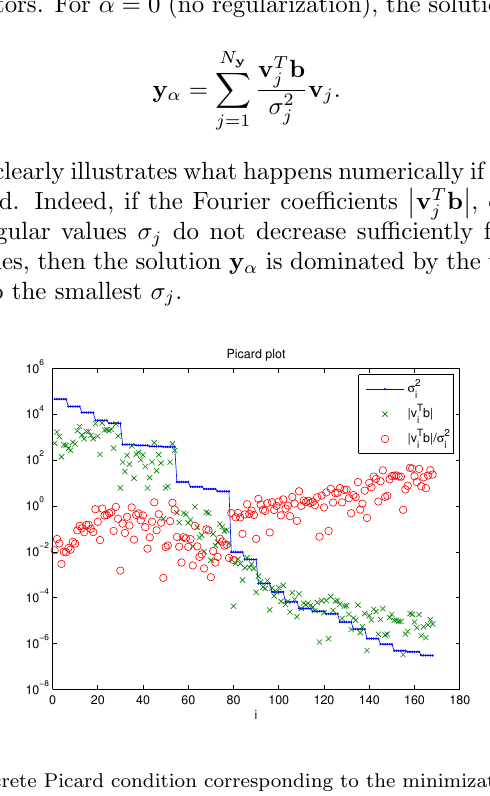
Figure 1. Discrete Picard condition corresponding to the minimization of J ( y ) with determination of all the coefficients (constant, linear and quadratic) for the cylinder wake configuration presented in Section